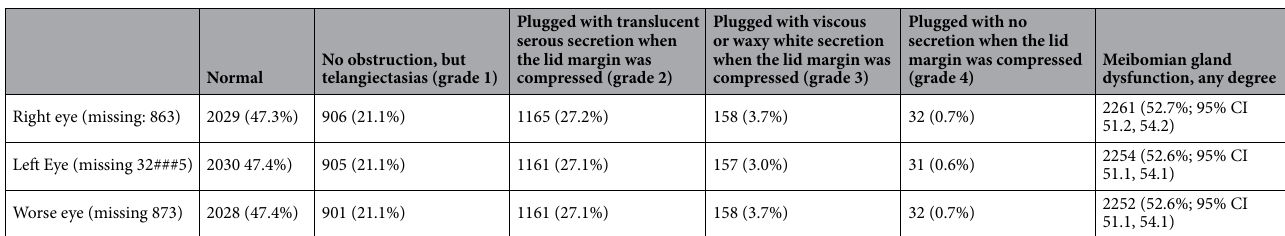
Table 2. Prevalence of Meibomian gland